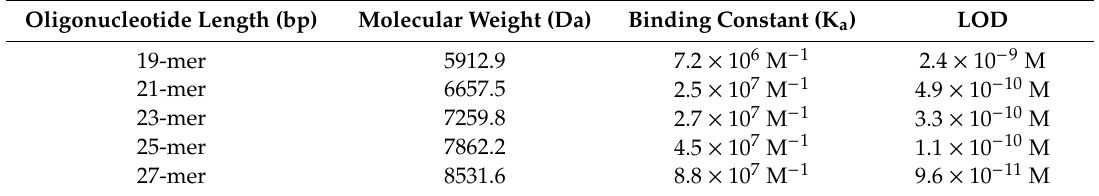
Figure 4. ( a ) A typical sensorgram using a 25-mer ssDNA probe for real-time detection of 25-mer target ssDNA upon sequential injection of standard solutions, where step 1 to step 10 represent concentrations 2.5 × 10 − 10 , 5.0 × 10 − 10 , 1 × 10 − 9 , 5 × 10 − 9 , 1 × 10 − 8 , 5 × 10 − 8 , 1.0 × 10 − 7 , 2.5 × 10 − 7 , 5.0 × 10 − 7 , 1 × 10 − 6 M, respectively. ( b ) The plots of I / I 0 versus target ssDNA concentration for both complementary ssDNA (c-ssDNA, blue square) and non-complementary ssDNA (nc-ssDNA, black diamond). Table 2. LOD and K a comparison obtained by FOPPR biosensor with ssDNA probes of different oligonucleotide lengths.